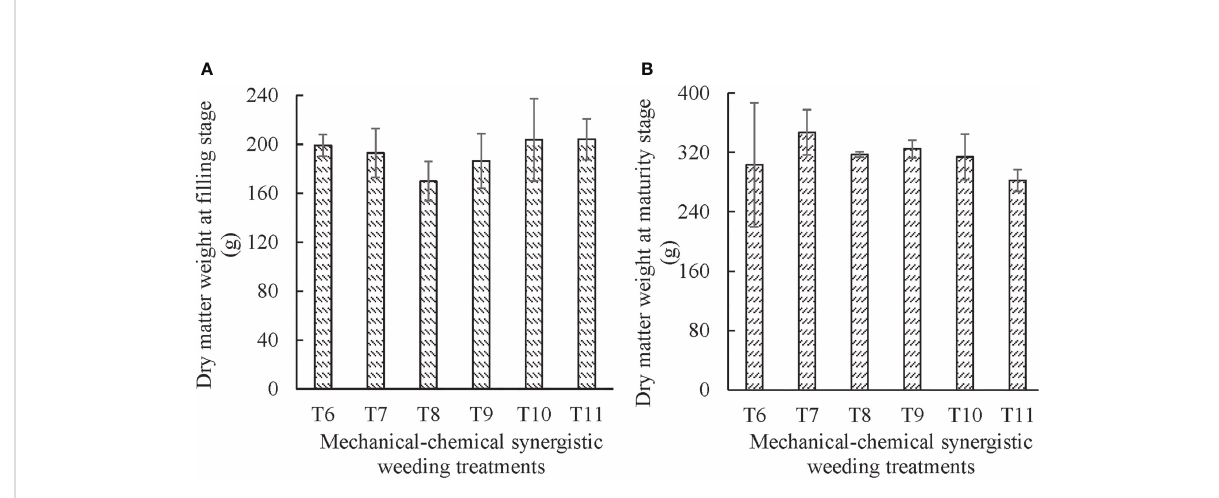
FIGURE 4 Effects of different synergistic weeding treatments on dry matter weight of maize (A) , at fi lling stage and (B) , at maturity